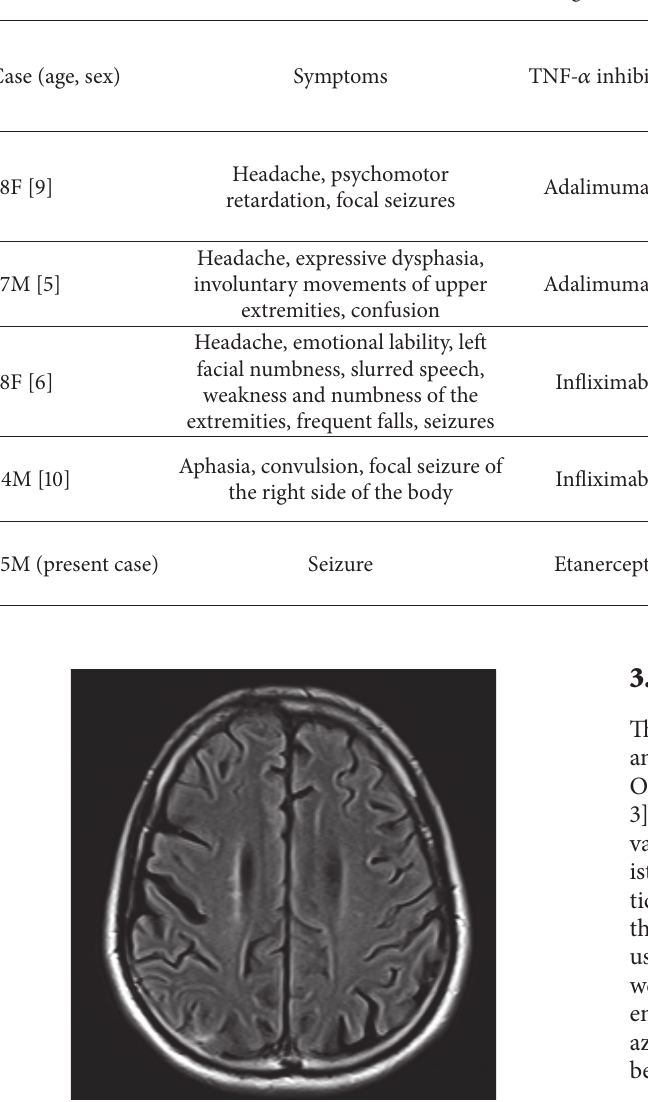
Table 1: Cases of rheumatoid meningitis during treatment with a TNF- 𝛼 blocker.